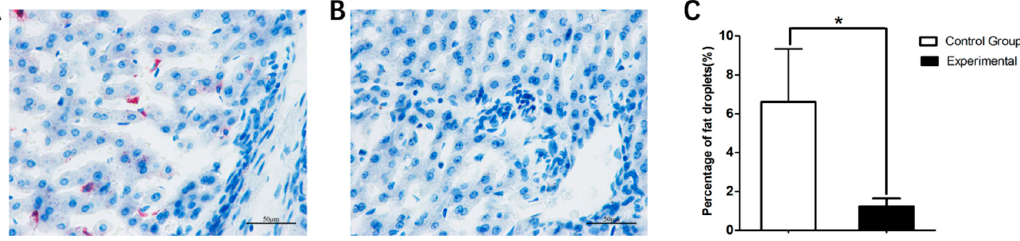
Figure 6. Effects of fasting caecotrophy on serum biochemical indices ( A : total cholesterol (TC); B : triglycerides (TG); C : total protein (TP); D : high-density lipoprotein cholesterol (HDL-C); E : low-